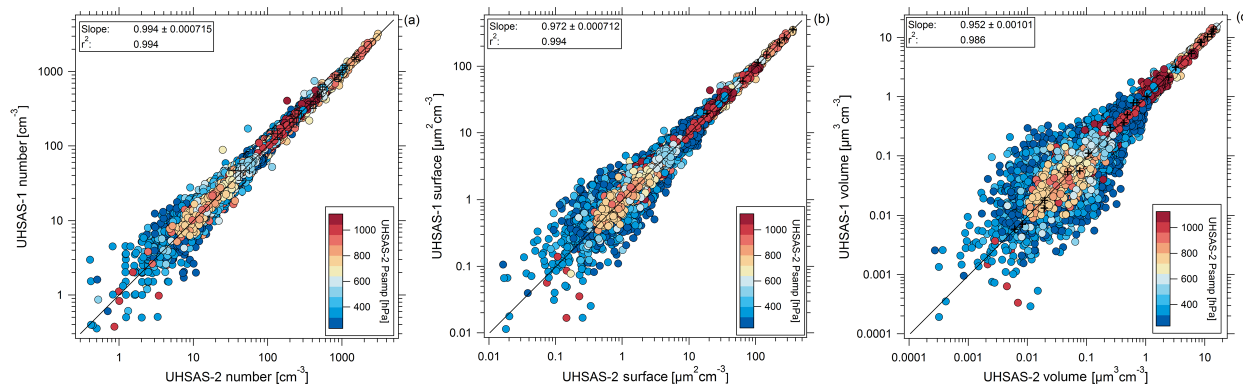
Figure 10. Comparison between the UHSAS-1 and UHSAS-2 instruments on ATom-1 from 29 July to 8 August 2016 for (a) dry particle number, (b) surface area, and (c) and volume concentrations for diameters from 0.1 to 0.9µm. Each point is a 10s average. The r 2 values indicated here refer to one-sided linear fit, while the solid lines represent double-sided orthogonal distance regression linear fits to non- transformed data. Estimated uncertainty is shown on a subset of points.